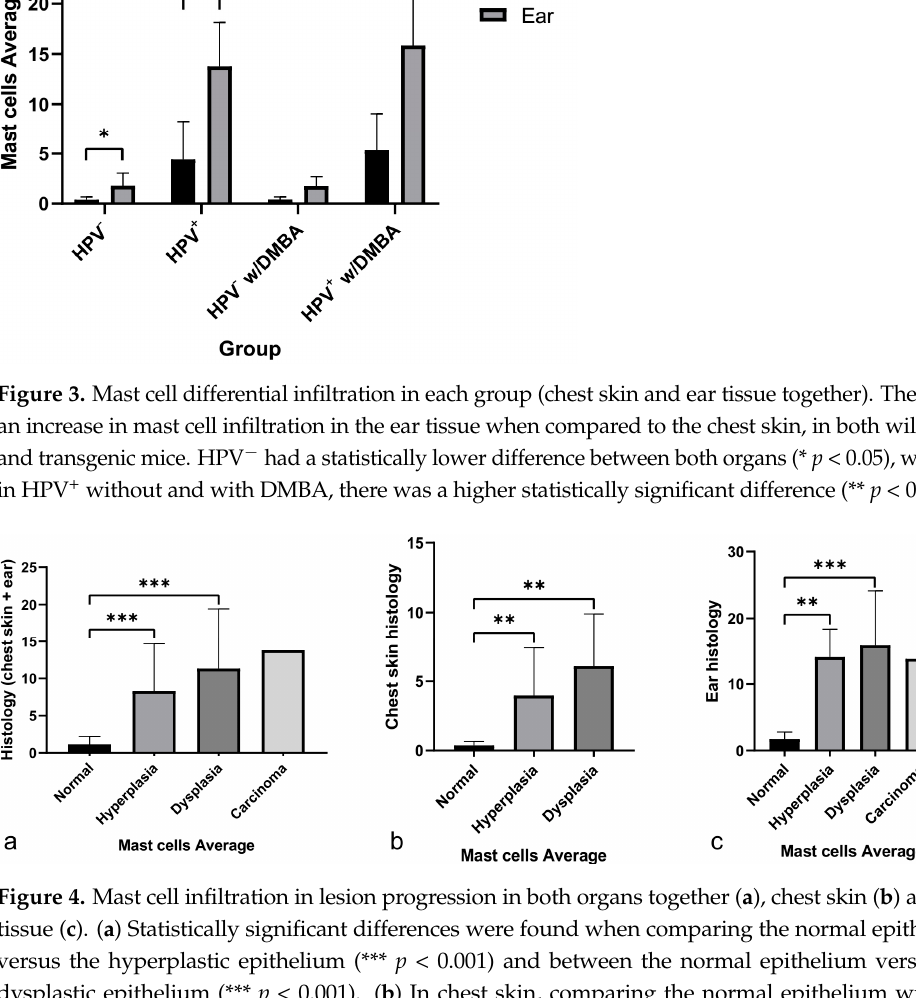
epithelium (** p < 0.01) and between the normal and dysplastic epithelium (*** p < 0.001). 0.001).